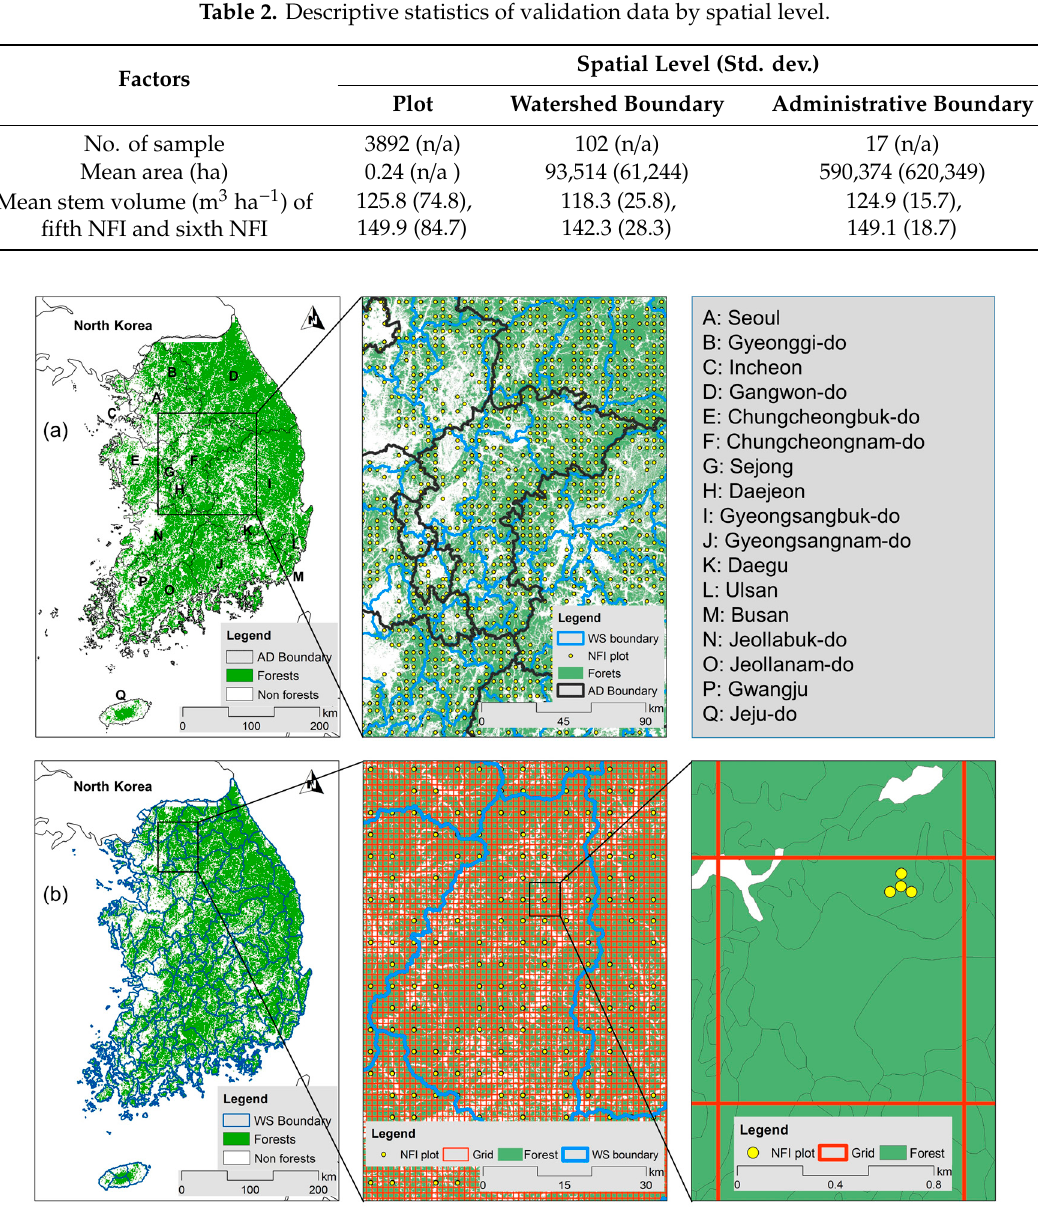
Figure 3. ( a ) Administrative boundaries of South Korea and an example of administrative-level spatial data for model validation. ( b ) Watershed boundaries of South Korea and an example of watershed-level and plot-level spatial data for model validation.